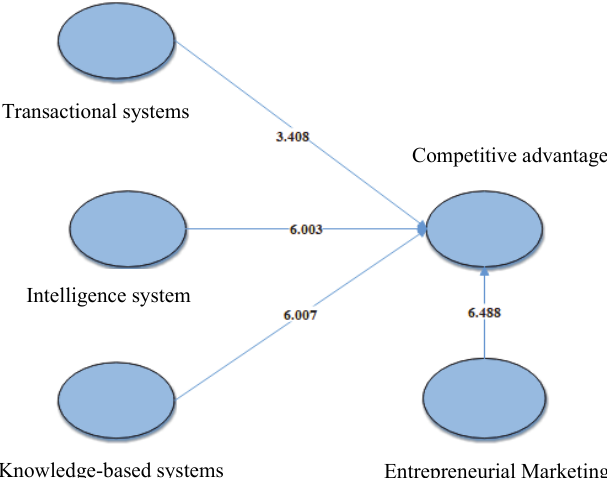
Fig. 3. Structural Model